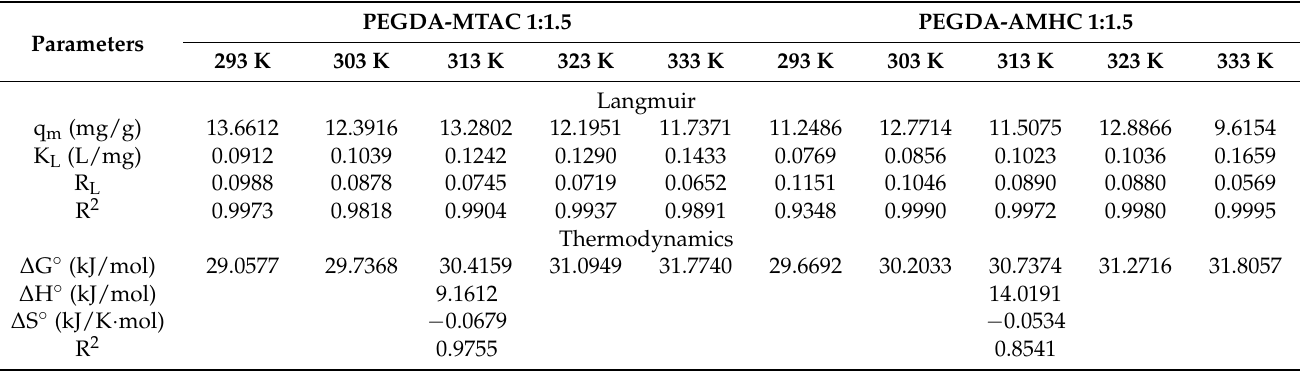
Table 5. Langmuir isotherm and thermodynamic parameters for adsorption nitrate by M 1.5 and N